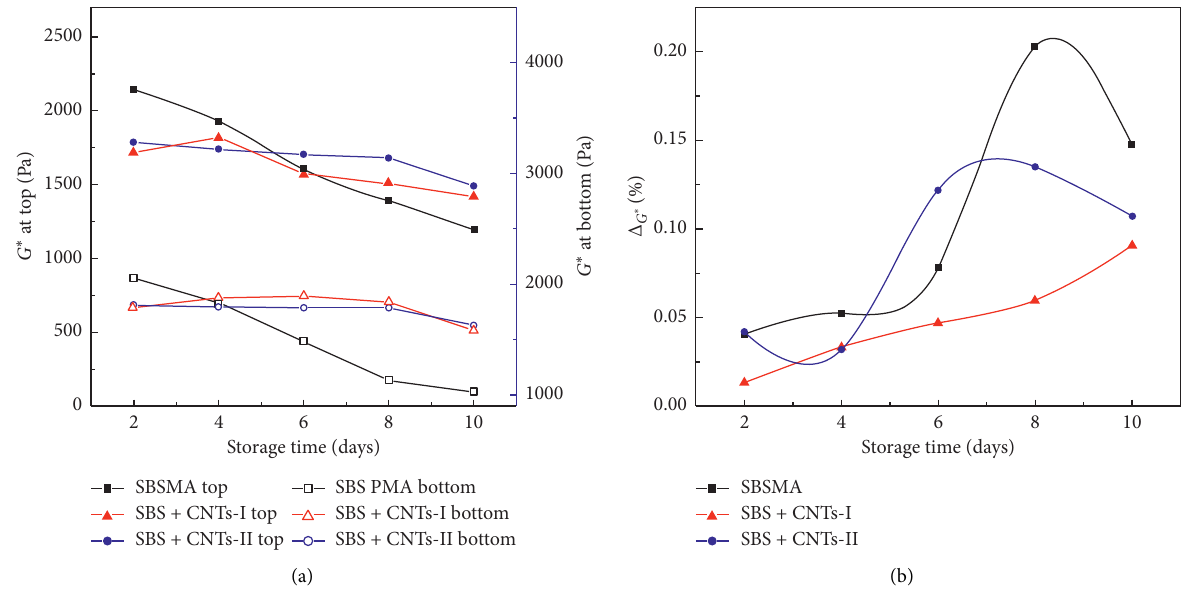
Figure 11: Difference in complex modulus ( G ∗ ) and separation degree based on G ∗ ( △ G ∗ ) of the three modified asphalts stored for 10 days. (a) G ∗ changes of asphalt samples. (b) △ G ∗ of asphalt